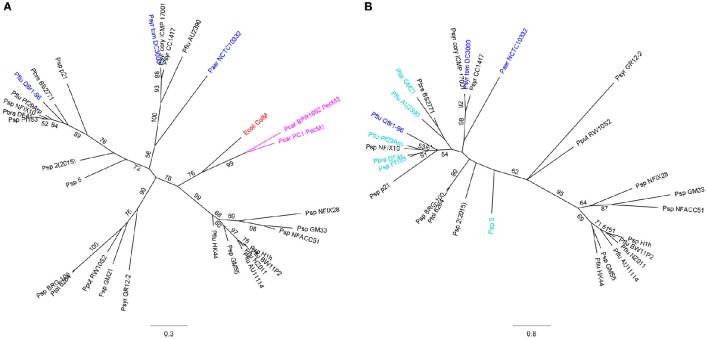
Maximum likelihood phylogenetic trees of ColM domains from pmiA-associated PseuMs and from related γ-proteobacterial bacteriocins (A), and of associated Pseudomonas PmiA immunity proteins (B). Characterized PseuM bacteriocins and cognate PmiAs are colored blue, colicin M (ColM) from E. coli is shown in red, and colicin M domain-containing pectocins (PecM1 and PecM2) in pink. PmiAs that were studied for promiscuity are shown in teal. The scale bars represent 0.3 (A) and 0.8 (B) substitutions per site. Bootstrap values (percentages of 1000 replicates) higher than 50 are shown at the branches. (A) For highly homologous colicin M domains (>95% pairwise AA identity), only one representative was included for phylogenetic tree construction. Species abbreviations: Ecoli, Escherichia coli; Paer, Pseudomonas aeruginosa; Pbra, Pseudomonas brassicacearum; Pbre, Pseudomonas brenneri; Pcar, Pectobacterium carotovorum; Pflu, Pseudomonas fluorescens; Pput, Pseudomonas putida; Psp, Pseudomonas sp.; Psyr, Pseudomonas syringae; Psyr cory, P. syringae pv. coryli; Psyr tom, P. syringae pv. tomato; Ptol, Pseudomonas tolaasii.